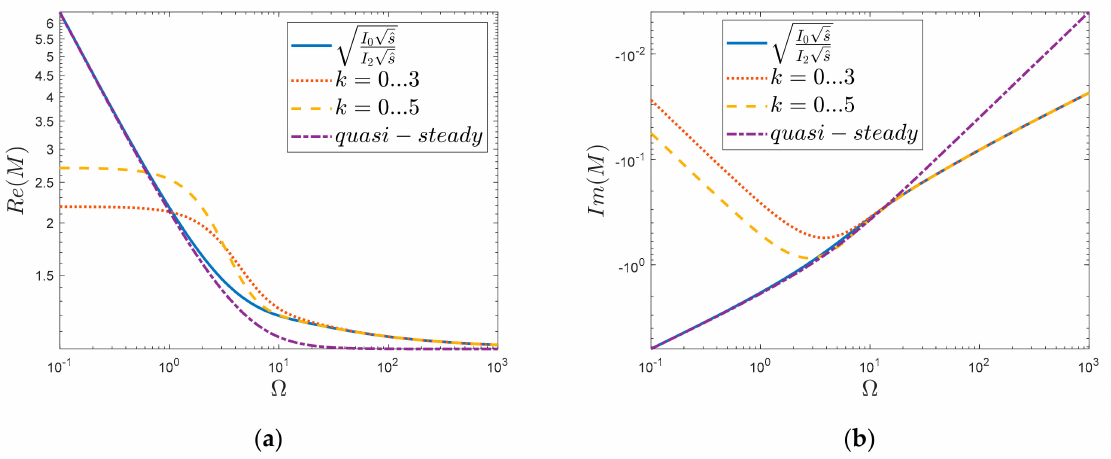
Figure 10. Comparison of novel solution received for initial power terms in the frequency domain: ( a ) Realis graph, ( b ) Imaginaris